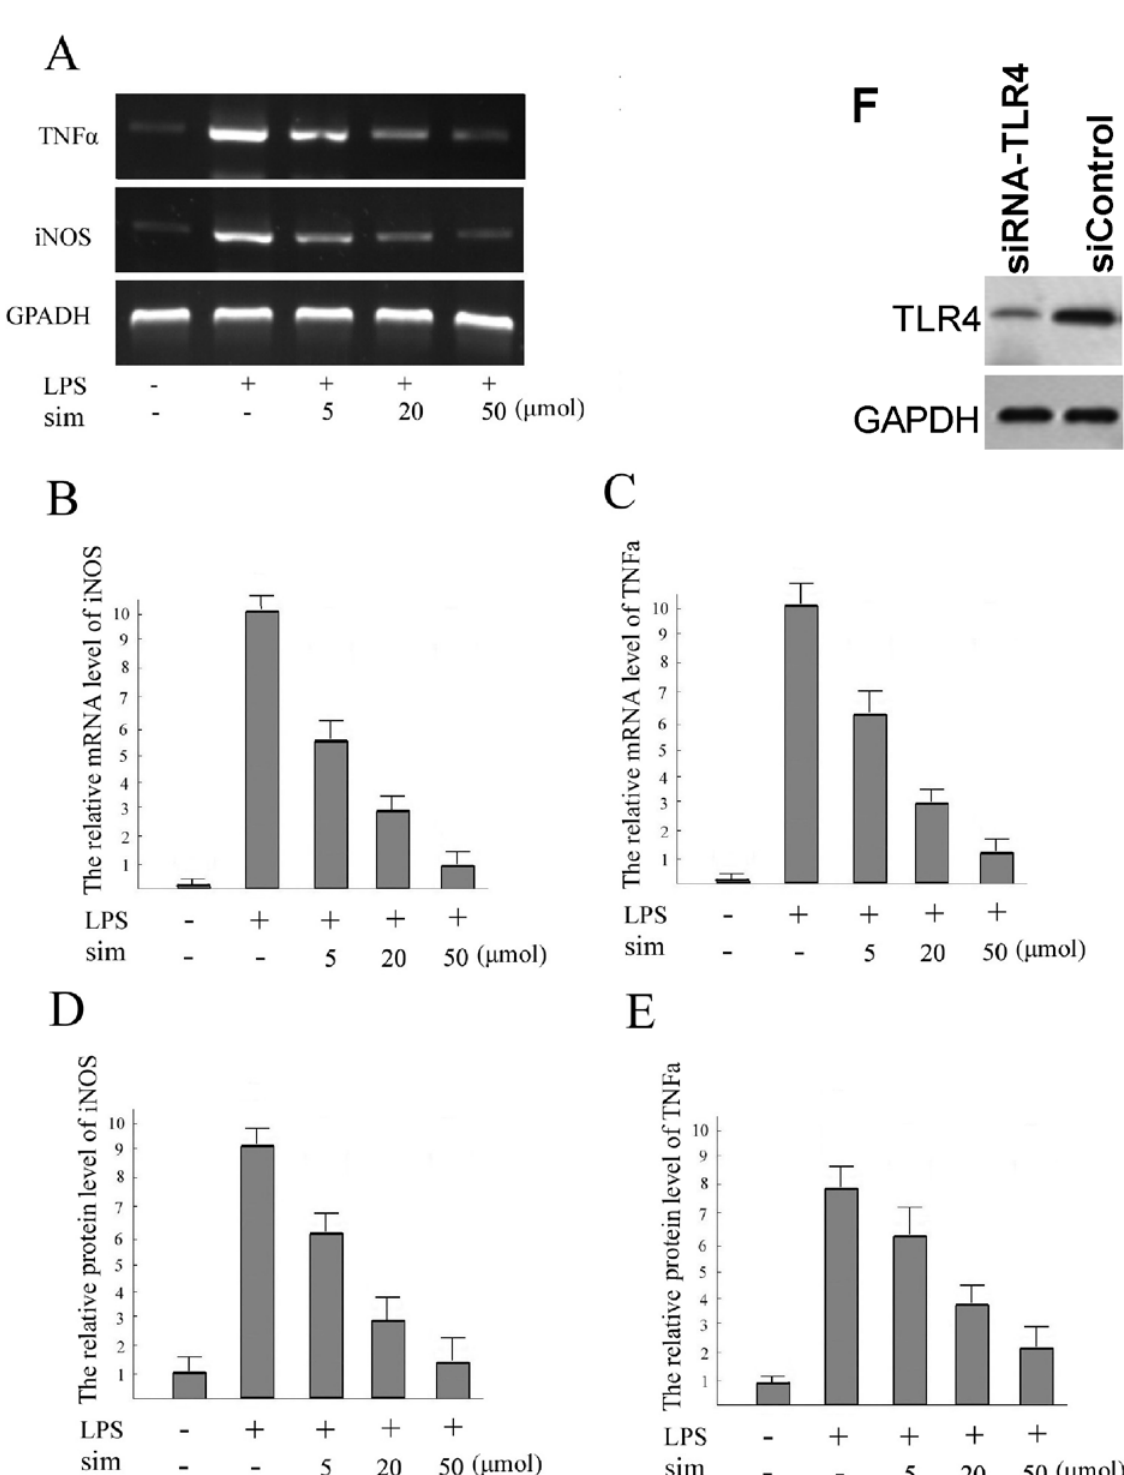
Figure 4. Simvastatin suppresses the LPS-induced inflammatory cytokines TNF-a and iNOS. A : Simvastatin suppresses the LPS- inducing the mRNA expression of TNF- a and iNOS in RPMVECs; B: Simvastatin suppresses the LPS-inducing the mRNA expression of iNOS in RPMVECs; C: Simvastatin suppresses the LPS-inducing the mRNA expression of TNF- a in RPMVECs; D: Simvastatin suppresses the LPS-inducing the protein expression of iNOS in RPMVECs; E: Simvastatin suppresses the LPS -inducing the protein expression of TNF- a in RPMVECs.; F: The interference of TLR4 by siRNA in